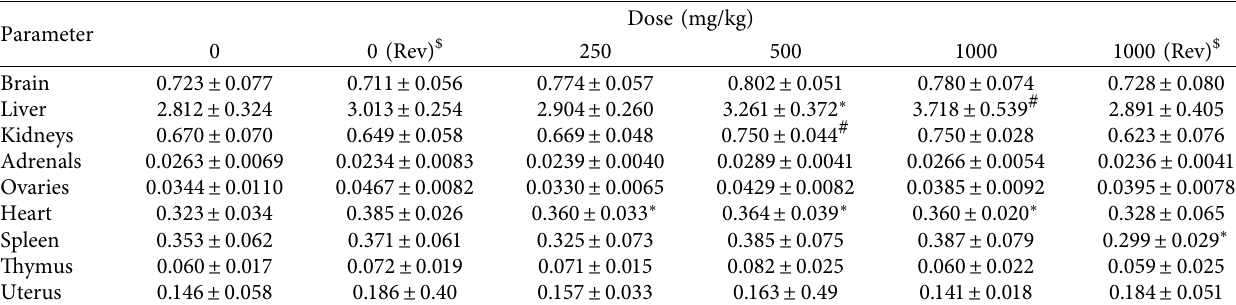
Table 12: Effect of GutGard on relative organ weights (%) of female rats during 90D oral toxicity study.